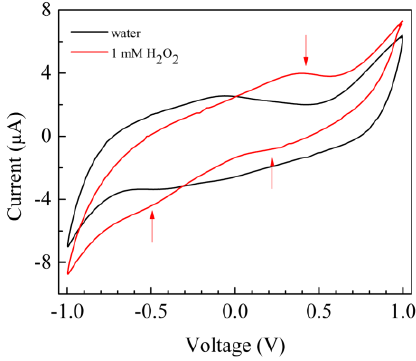
Figure 6. Current-voltage loop of the Au/chitosan–Cu-complex/chitosan/Au cell, measured in pure water, and in the presence of 0.5 mM hydrogen peroxide.